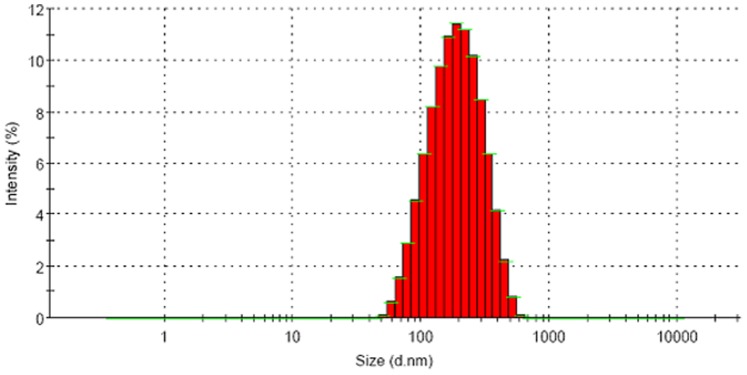
Particle size distribution of andrographolide TPGS nanoparticles.AGnp formulation showed a near perfect Gaussian size distribution. The particle size of AGnp preparations were measured in Photon Correlation Spectroscopy.